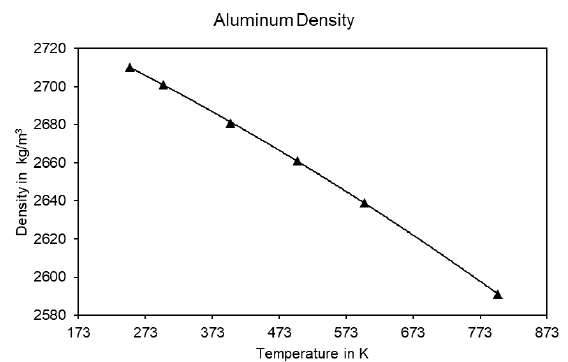
Figure A1. Aluminum density data from Rohsenow [40] and correlation (line).